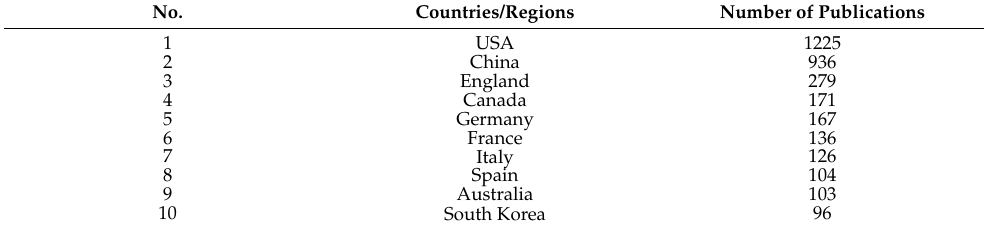
Table 1. Top 10 countries.